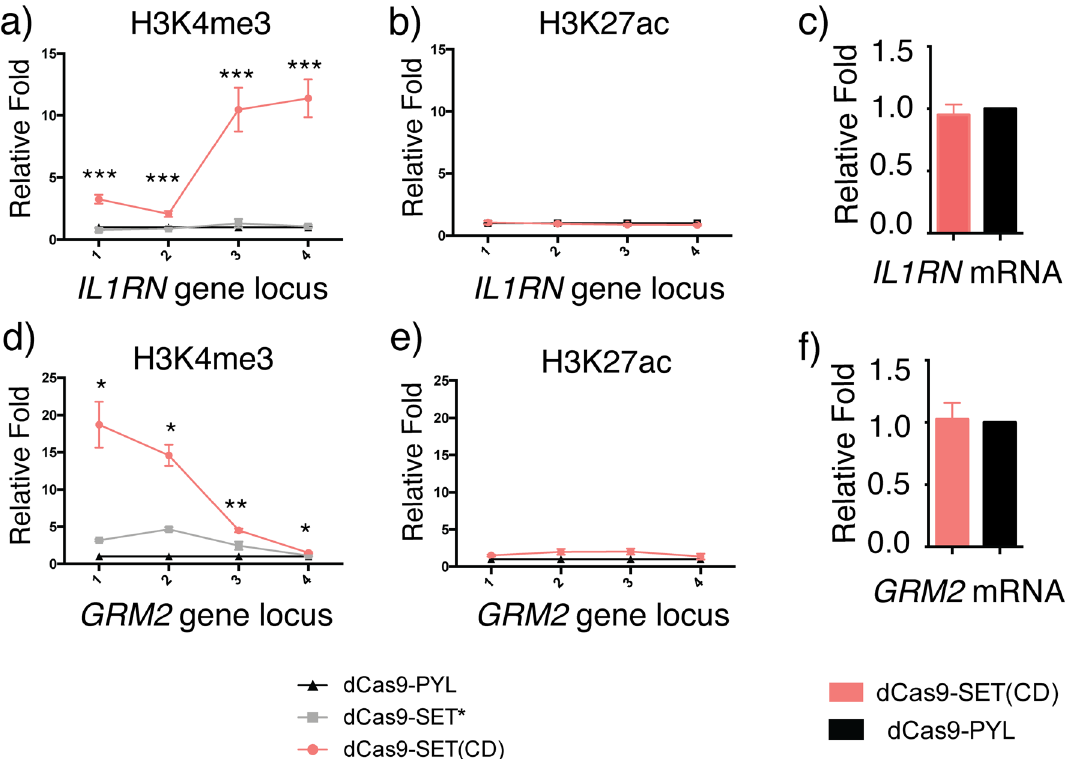
H3K27ac at ( b ) IL1RN and ( e ) GRM2 loci upon targeted dCas9-SET editing of H3K4me3. Changes in mRNA expression levels of ( c ) IL1RN and ( f ) GRM2 upon induced H3K4me3 writing. Fold changes of H3K27ac